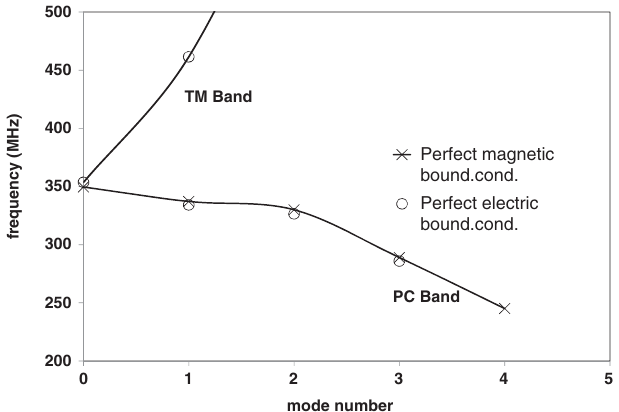
FIG. 4. Dispersion curves simulated with perfect electric bound- ary conditions and with perfect magnetic boundary conditions in a DTL with postcouplers, as shown in Fig. 3. Only perfect magnetic mode boundary conditions allow the PC 0